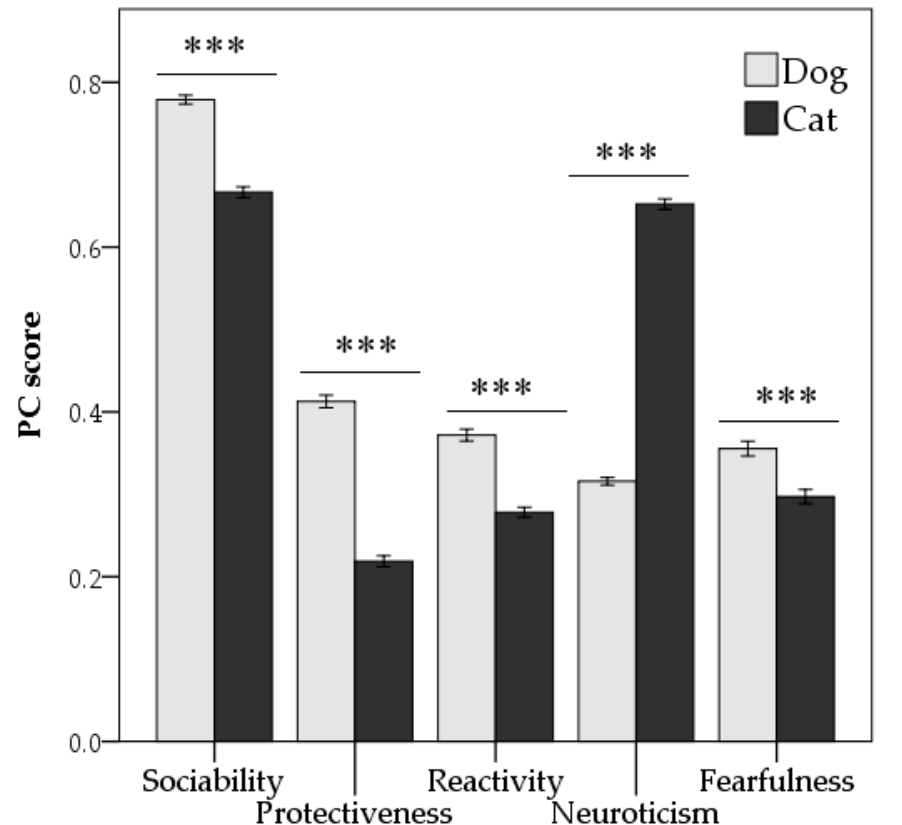
Figure 1. Comparison of personality traits, as extracted by principal component analysis, between dogs and cats living in the same household. Values are means ± standard error. *** p < 0.001 (paired t -test).